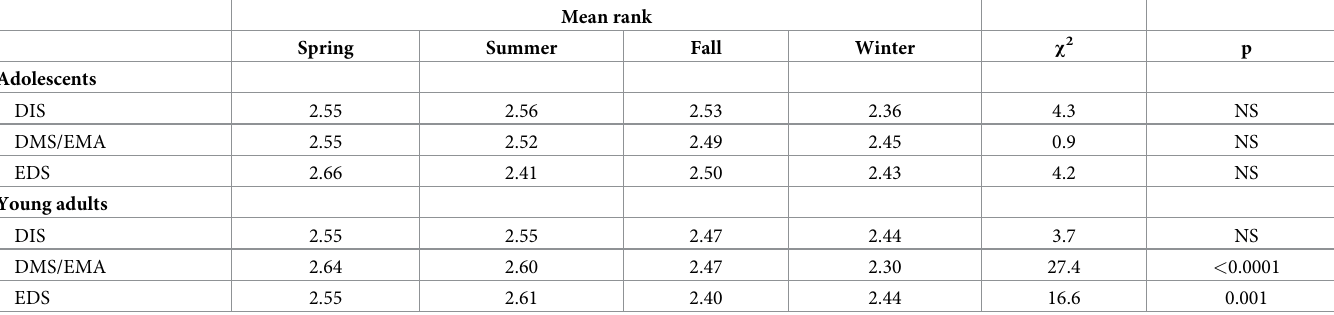
Table 8. Mean ranks of DIS, DMS/EMA, and EDS symptoms for each season in the adolescents and young adults.